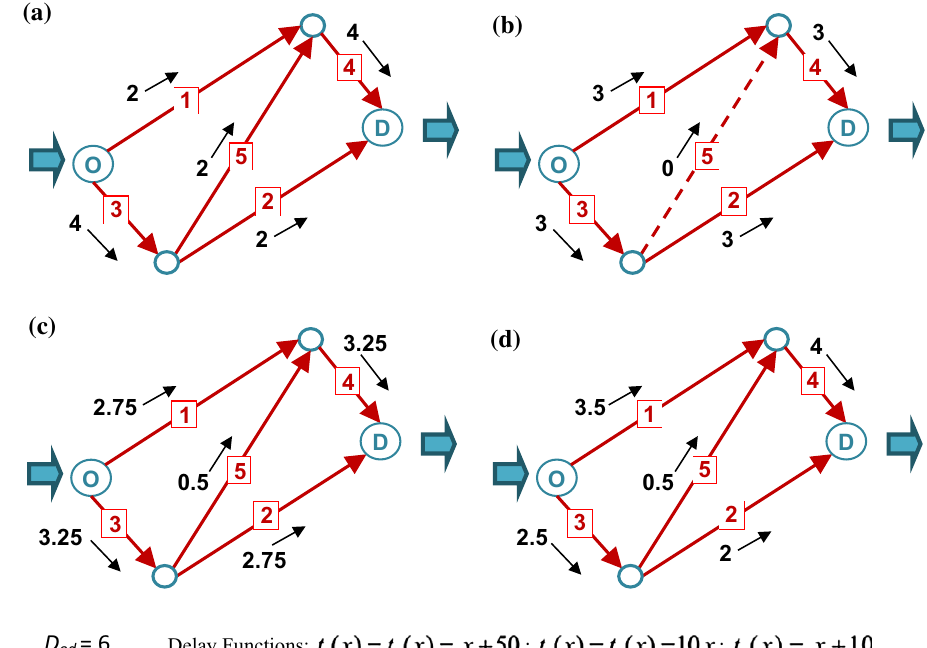
Fig. 3 Braess example, different pricing